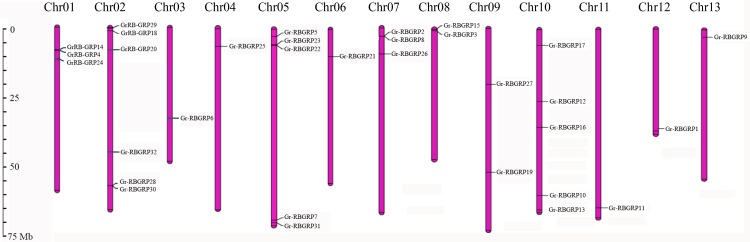
Chromosomal localization of RB-GRP genes in G.raimondii.The scale on the left was in megabases (Mb).